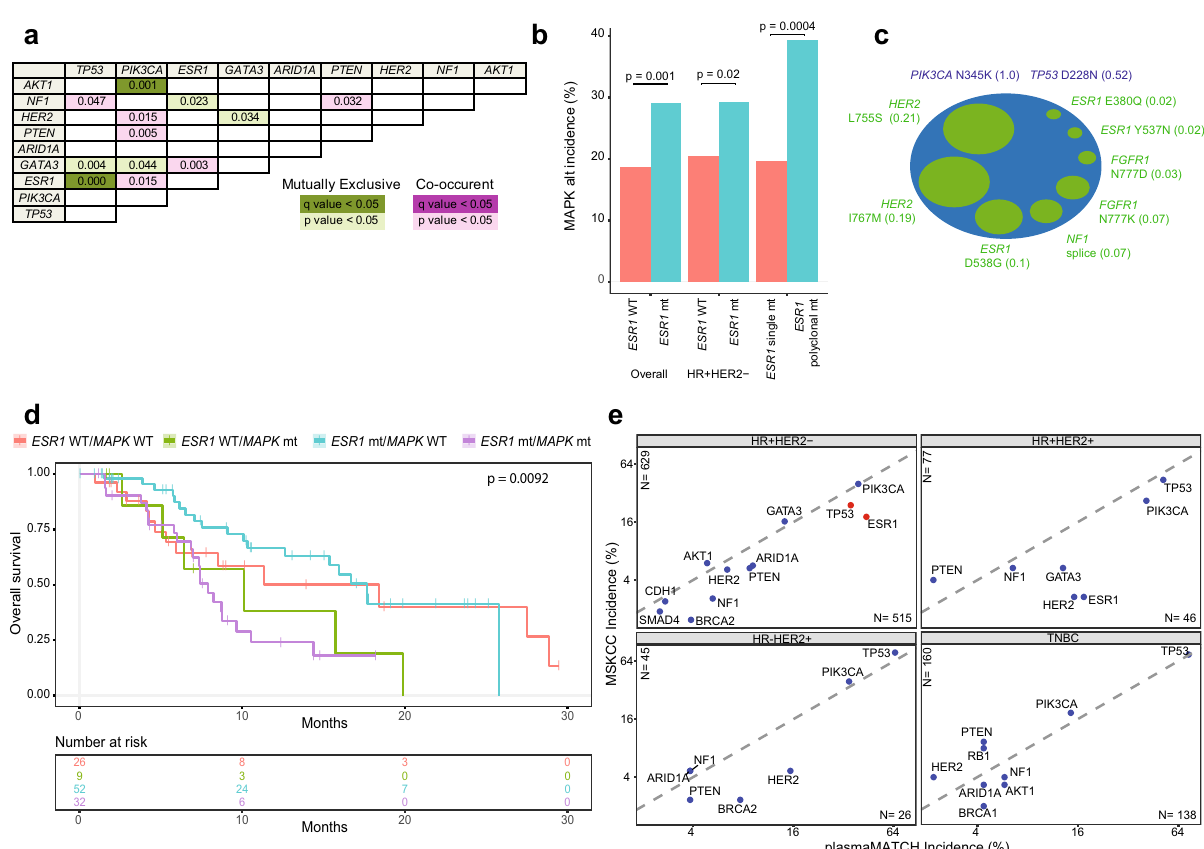
Fig. 2 Polyclonal resistance with co-enrichment of MAPK pathway and ESR1 mutations in advanced breast cancer. a Association analysis for most frequent mutated genes with overall Fisher ’ s exact test two-sided p -values. Green genes showing mutual exclusivity, and purple showing co-occurrence with dark colours indicating signi fi cance following false discovery correction. b Frequency of MAPK pathway alterations comparing ESR1 mutant (77/265) vs ESR1 wild-type cancers overall (100/535) ( left ), ESR1 mutant (66/226) vs wild-type (59/289) in HR + HER2- cancers ( middle ), and within ESR1 mutant cancers between patients with single (27/138) and polyclonal ESR1 mutations (50/127) ( right ). p -values from two-sided Fisher ’ s exact test. c Example of polyclonal genomic resistance in a patient with multiple MAPK pathway and ESR1 mutations in ctDNA. Blue indicate dominant mutations with cancer fraction, and green subclonal mutations with cancer fraction. d Overall survival (OS) in patients with HR + HER2- disease who entered a treatment cohort in plasmaMATCH divided by combined ESR1 and MAPK pathway mutation status. ESR1 WT and MAPK WT, median 18.5 months, hazard ratio (HR) -. ESR1 mt and MAPK WT, median 17.7 months, HR 0.82, 95% con fi dence interval (CI) 0.40 to 1.69. ESR1 WT and MAPK mt, median 10.1 months, HR 1.65, 95% CI 0.56 to 4.88. ESR1 mt and MAPK mt, median 7.9 months, HR 1.65, 95% CI 0.84 to 3.23. p -value from log-rank test. HR > 1 indicate worse OS for that group. WT, wild-type; mt, mutant. e Mutational pro fi le of ctDNA in plasmaMATCH ( N = 725 patients with known breast cancer subtype) compared to published large metastatic breast cancer tissue sequencing dataset (MSKCC, N = 715 patients with known breast cancer subtype) 11 . Red dots indicate signi fi cant change in frequency after false discovery adjusted two-sided Fisher ’ s exact test (HR + HER2-: ESR1 q < 0.0001, TP53 q = 0.0009). Included are genes with an incidence 1.5% in both data